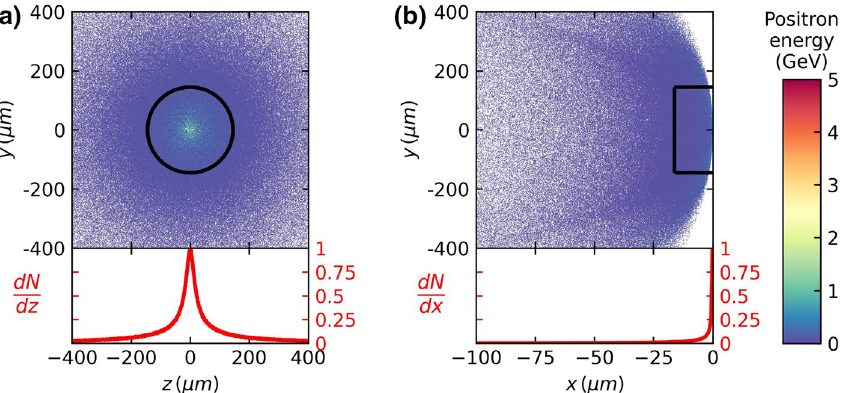
Figure 1. ( a ) Transversal distribution of the generated positrons. Each dot represents a positron and its color represents the kinetic energy of the positron. The normalized positron number density in the radial direction is shown as a red curve. ( b ) Longitudinal distribution of the generated positrons. The black rectangle represents the dimensions of the positron beam. The thickness of the box is set as one standard deviation, δ x , of the positrons along the x- axis within r median . The red curve represents the normalized positron number density dN within r median along the x -axis normalized by its peak value at x = 0, dx (right vertical axis). The driver electron energy is 5 GeV, and the lead converter thickness is L rad